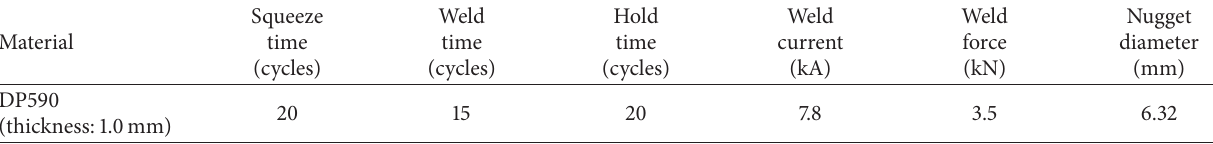
Table 2: Welding schedule and associated nugget diameter of DP590.